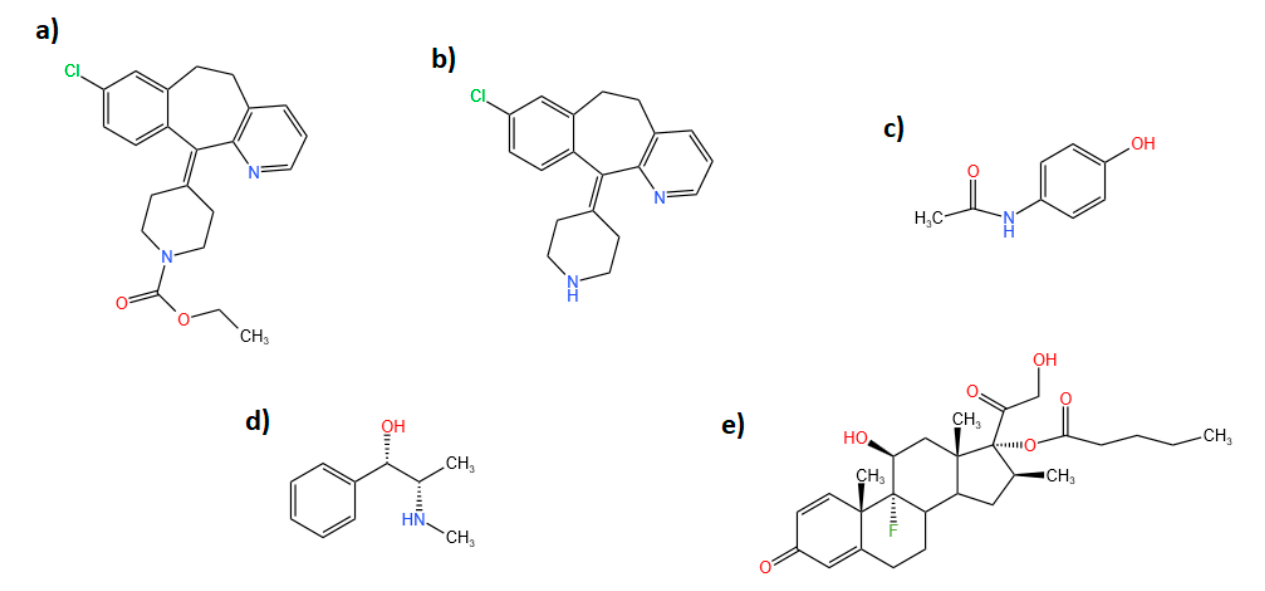
Figure 1. Chemical structures of ( a ) loratadine, ( b ) desloratadine, ( c ) paracetamol, ( d ) pseudoephedrine, and ( e ) betamethasone valerate (IS) .